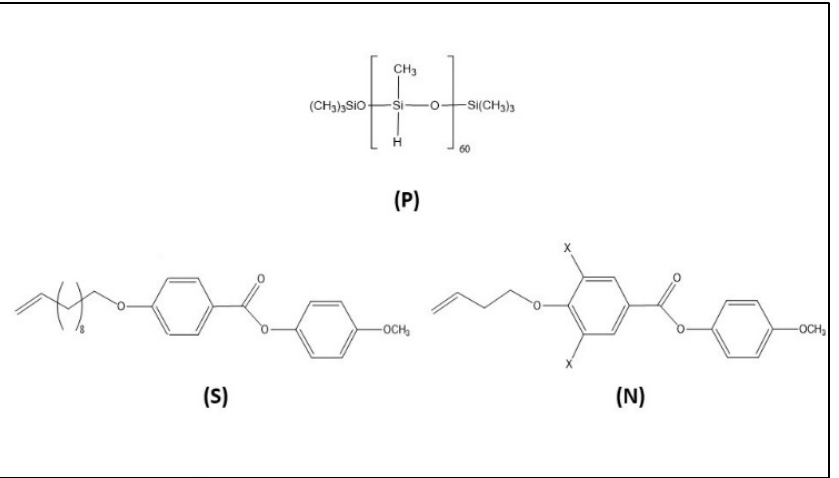
Figure 1. Compounds used in the synthesis of LCE systems: ( P ) hydroxymethyl polysiloxane polymeric chain; ( S ) smectic comonomer, M11; ( N ) nematic comonomer, M4. X = 1 H for the not labelled SC-LCEs, while X = 2 H for the deuterated SC-LCEs. (The structure of the crosslinker, C, is shown in Scheme 1).